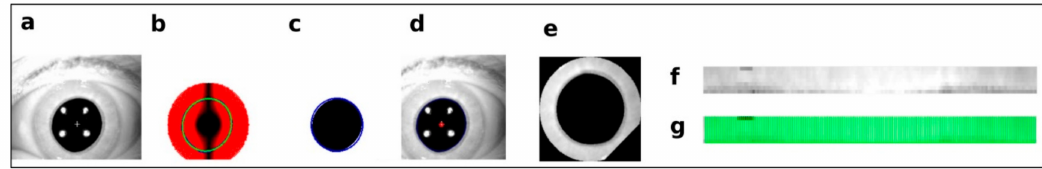
Figure 2. Image processing order. ( a ) Original frame, ( b ) circle Hough Transform followed by edge detection, ( c ) binarization by a threshold value, ( d ) pupil center and pupil area determined by ellipse fitting, ( e ) iris area selected, ( f ) iris image from the previous frame (reference image) after polar transformation (rotated 90 ◦ counterclockwise), and ( g ) iris image from the current frame (template image) with overlapping patches (rotated 90 ◦ counterclockwise).